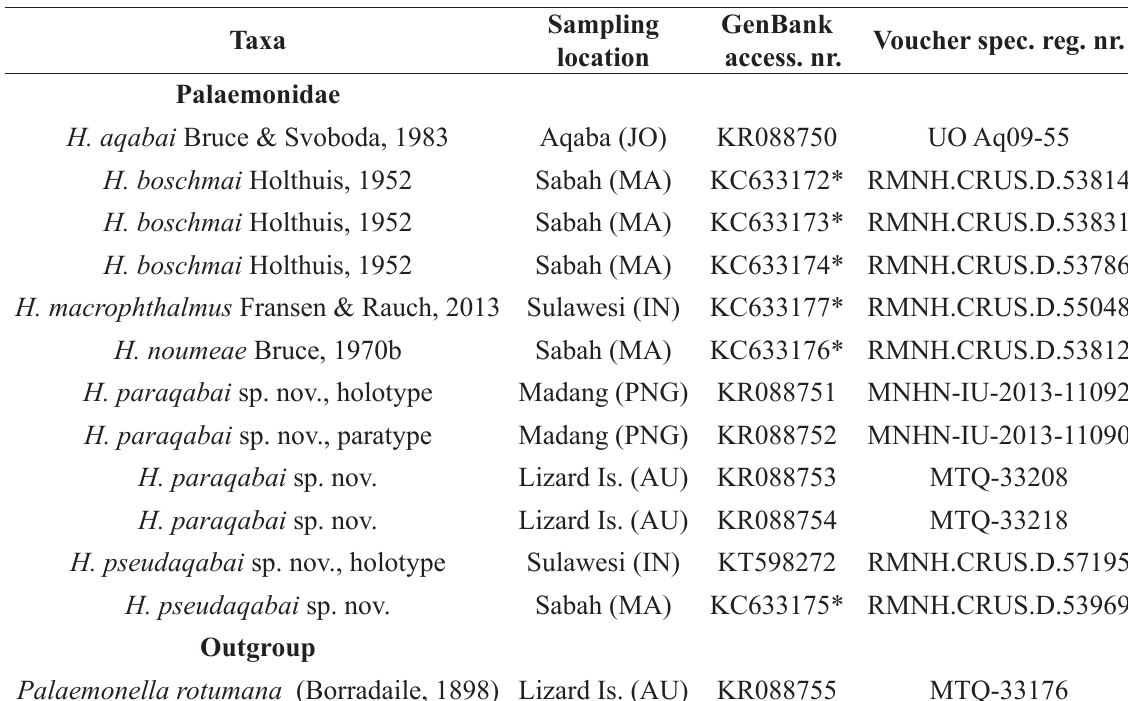
Table 1. Species used in the molecular analysis, with details on sampling locations, GenBank accession numbers (COI) and voucher identification numbers of specimens examined. AU = Australia; IN = Indonesia; JO = Jordan; MA = Malaysia; PNG = Papua New Guinea; * = sequences obtained from